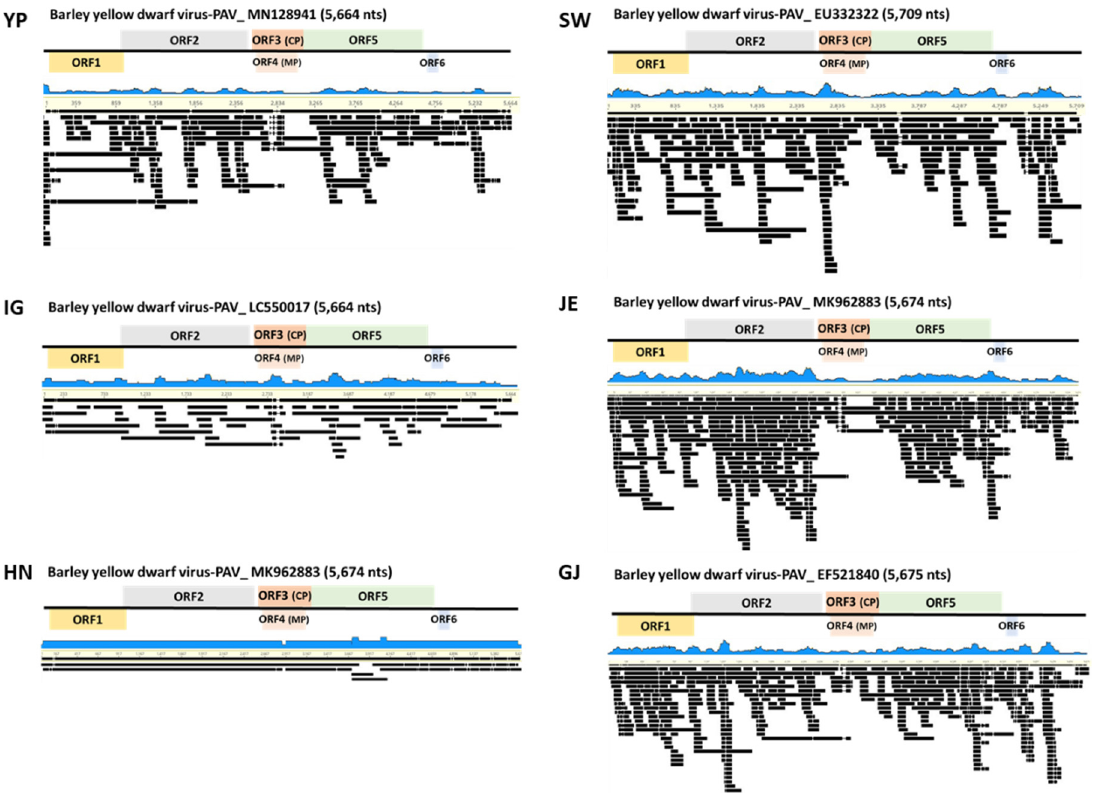
Figure 3. Viral genome assembly of identified BYDV-PAV isolates. Genome organization of assembled BYDV-PAV isolates genome of YP, SW, IG, JE, HN, and GJ. Viral genomes were obtained from assembled virus-associated contigs and their mapping on the reference virus genome.